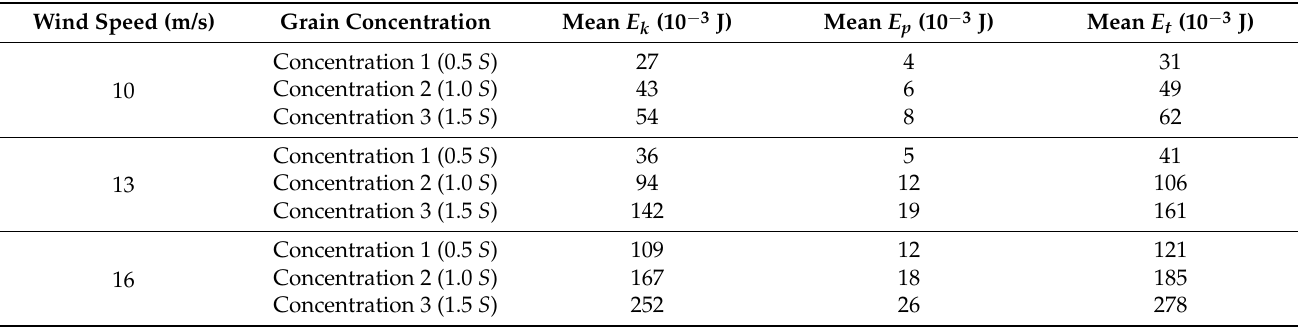
Table 4. The average energy of grains at all